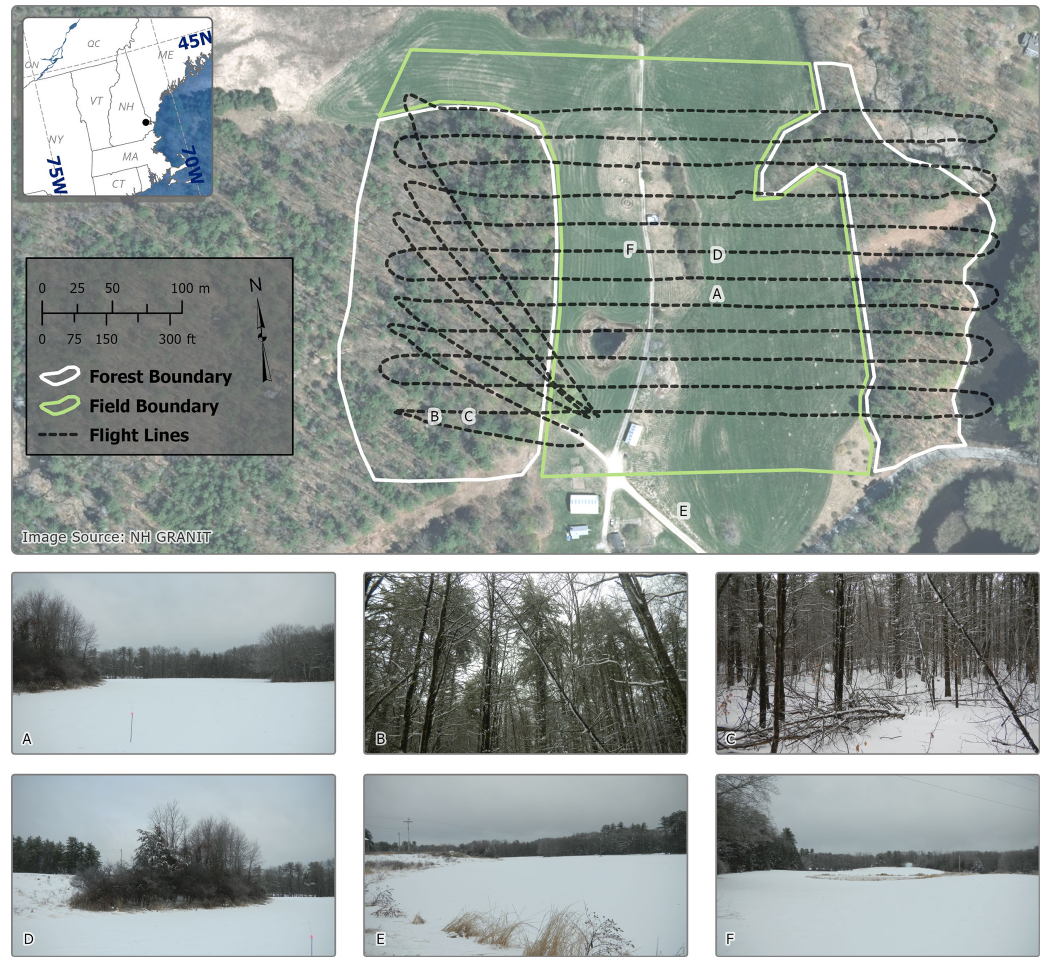
Figure 1. Aerial imagery of Thompson Farm, Durham, NH, from 2015 showing both forest and field regions with lidar flight lines (top). Ground imagery (A to F) collected in December 2019; locations are noted on the top map and show the surface and leaf-off forest conditions (bottom